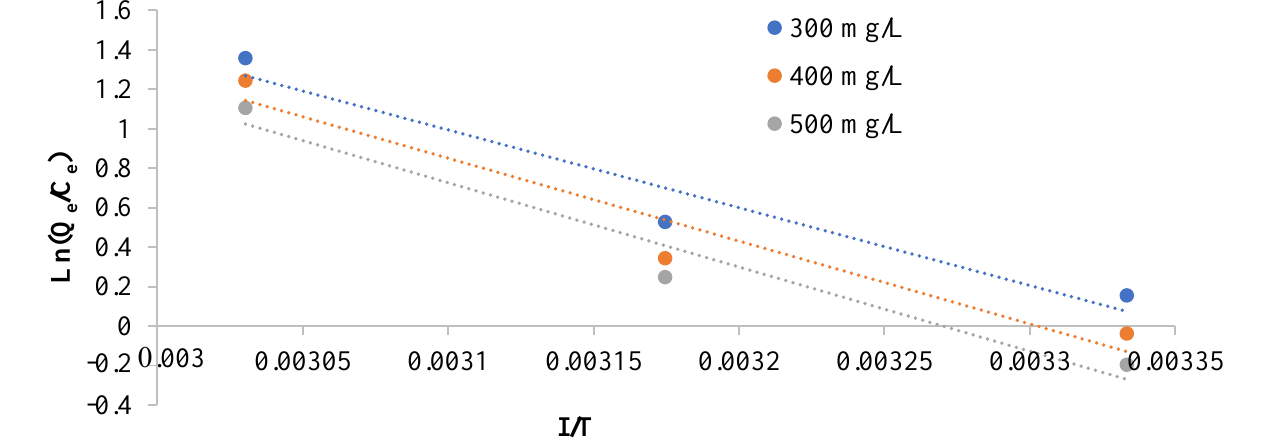
Figure 8. Thermodynamic plots for adsorption of CR by Zn/Cu − FVSP. Table 5. Thermodynamic constants for CR adsorption onto Zn/Cu-FVSP. CR Concentration (mg/L)